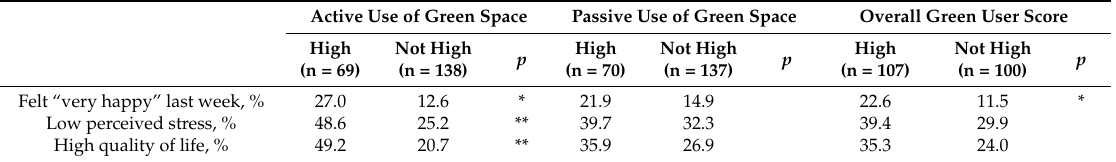
Table 2. Measures of well-being according to High versus Not High Active Use of Green Space, Passive Use of Green Space, and Overall Green User Score (n = 207). Active Use of Green Space Passive Use of Green Space Overall Green User